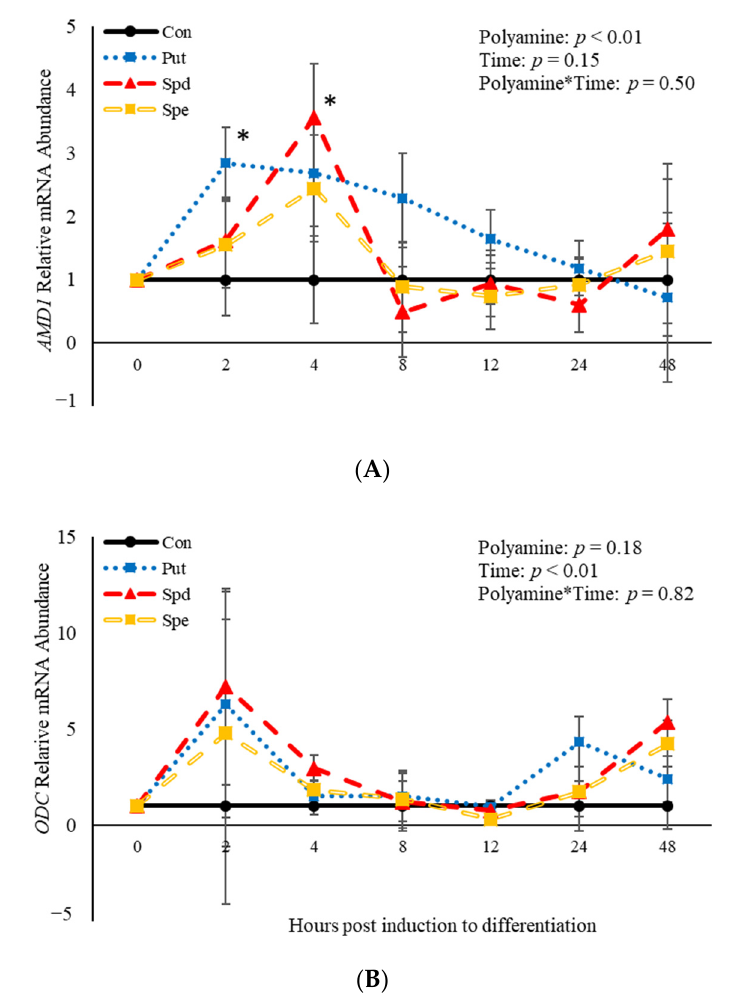
Figure 7. Relative mRNA abundance of S-adenosylmethionine decarboxylase ( AMD1; A ) and ornithine decarboxylase (ODC; B ) from primary bovine satellite cells cultures following treatment with 2 mM putrescine (PUT), 1.5 mM spermidine (SPD) or 0.5 mM spermine (SPE). Cultures were grown to 80% confluency and treated with DMEM/3% horse serum and 2 mM PUT, 1.5 mM SPD, or 0.5 mM SPE. Cultures were grown to 80% confluency and treated with DMEM/3% horse serum and 10 nM TBA, 10 nM E2, or 10 nM E2/TBA. Abundance was measured 0, 2, 4, 8, 12, 24 and 48 h after treatment, as described in the Materials and Methods. The main effects of polyamine, time and polyamine*time in mRNA abundance were analyzed as repeated-measures. Data represent relative mRNA abundance normalized against 18S abundance and are presented as LS mean ± SEM from six separate replicates utilizing BSCs isolated from at least three different animals. Differences ( p < 0.05) between polyamines and the control cultures are indicated by a * at that particular time point.